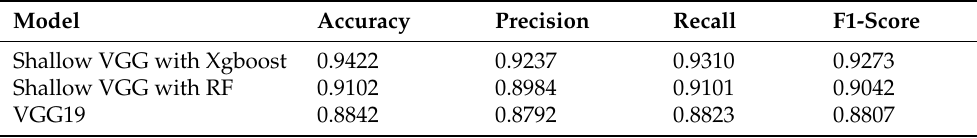
Table 9. Performance evaluation on corn field